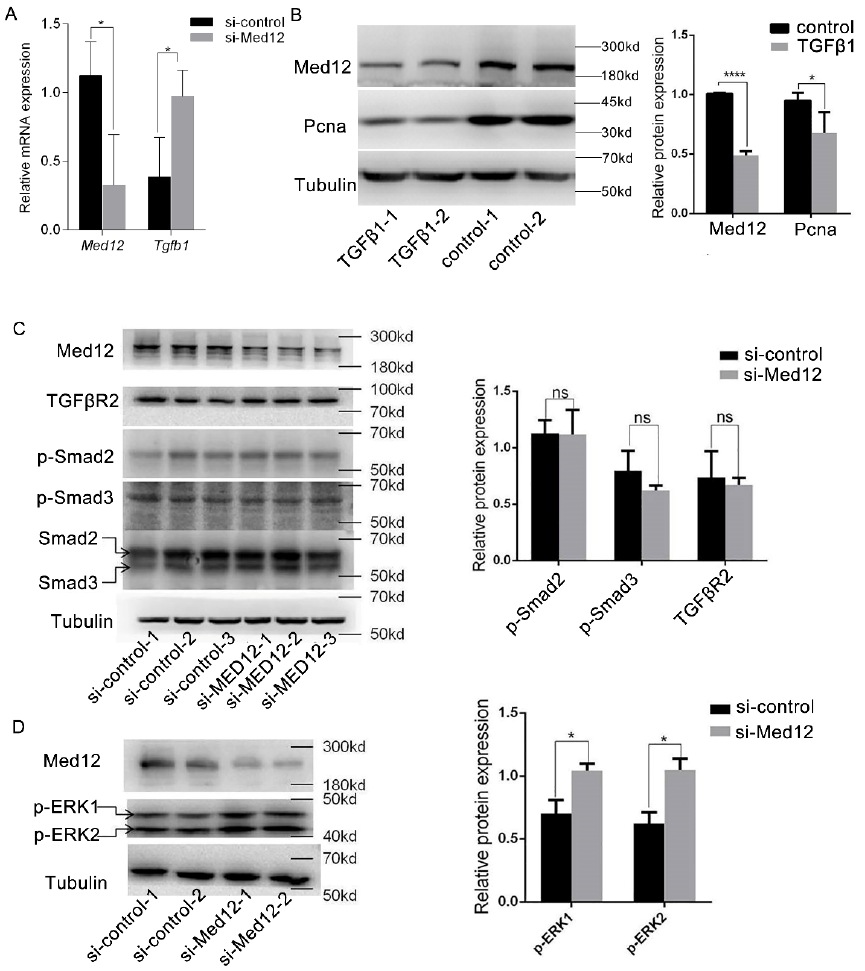
Figure 5. Effect of Med12 on the TGF β signaling pathway. ( A ) MOVAS were translated with si- control or si-Med12 for 72 h, and the expressions of Tgf β 1 were detected by RT-PCR. ( B ) MOVAS were incubated with TGF β 1(4 ng/mL) for 72 h, and Western blot detected the expression of Med12 and Pcna. ( C ) Same experiment as in ( A ); the TGF β R2-phosphorylated Smad2 (p-Smad2) relative to total Smad2 and phosphorylated Smad3 (p-Smad3) relative to total Smad3, as detected by Western blot. ( D ) Same experiment as in ( A ), Western blot was used to analyze p-ERK/ERK. The experiment was repeated at least three times. Data are expressed as mean ± SD. Statistical analyses, unpaired t- test. * p < 0.05; **** p < 0.0001. ns: not significant.